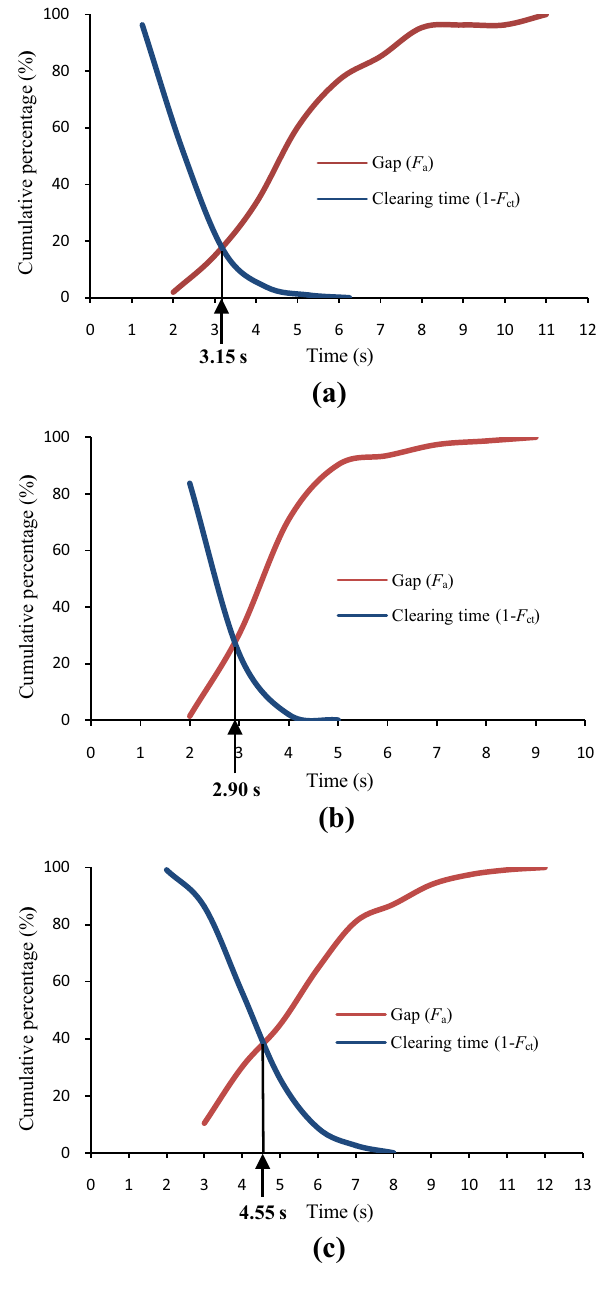
Fig. 10 Estimation of critical gap by clearing behavior approach for a intersection A b intersection B and c intersection